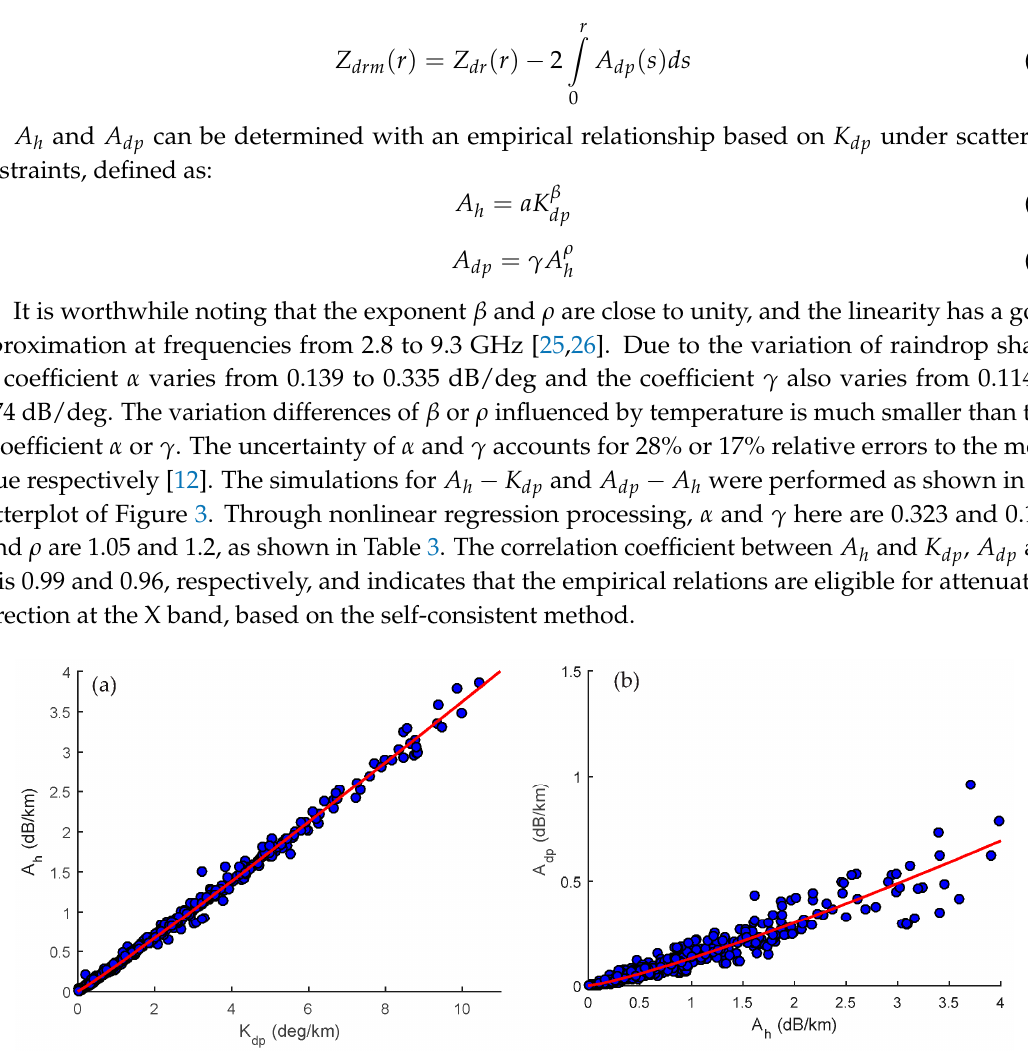
Figure 3. Scattergram of A h , A dp and K dp derived from rain drop size distribution (DSD) data for fifteen rainfall events. The power law relations between attenuation and specific differential phase are derived: ( a ) A h = 0.323 K 1.05 ; ( b ) A dp = 0.131 A 1.2 . Table 3. Coefficients for the relations of A h , A dp ( A h ) , and K dp ( Z h , Z dr ) , at X-band. These polarimetric observables are simulated by T-matrix